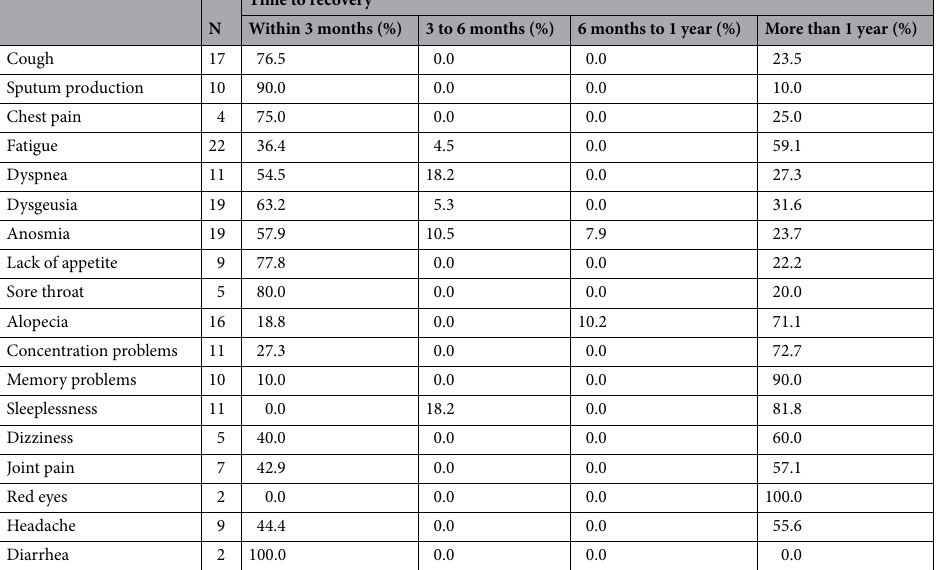
Table 4. Time to recovery of each symptom in Mild Group.